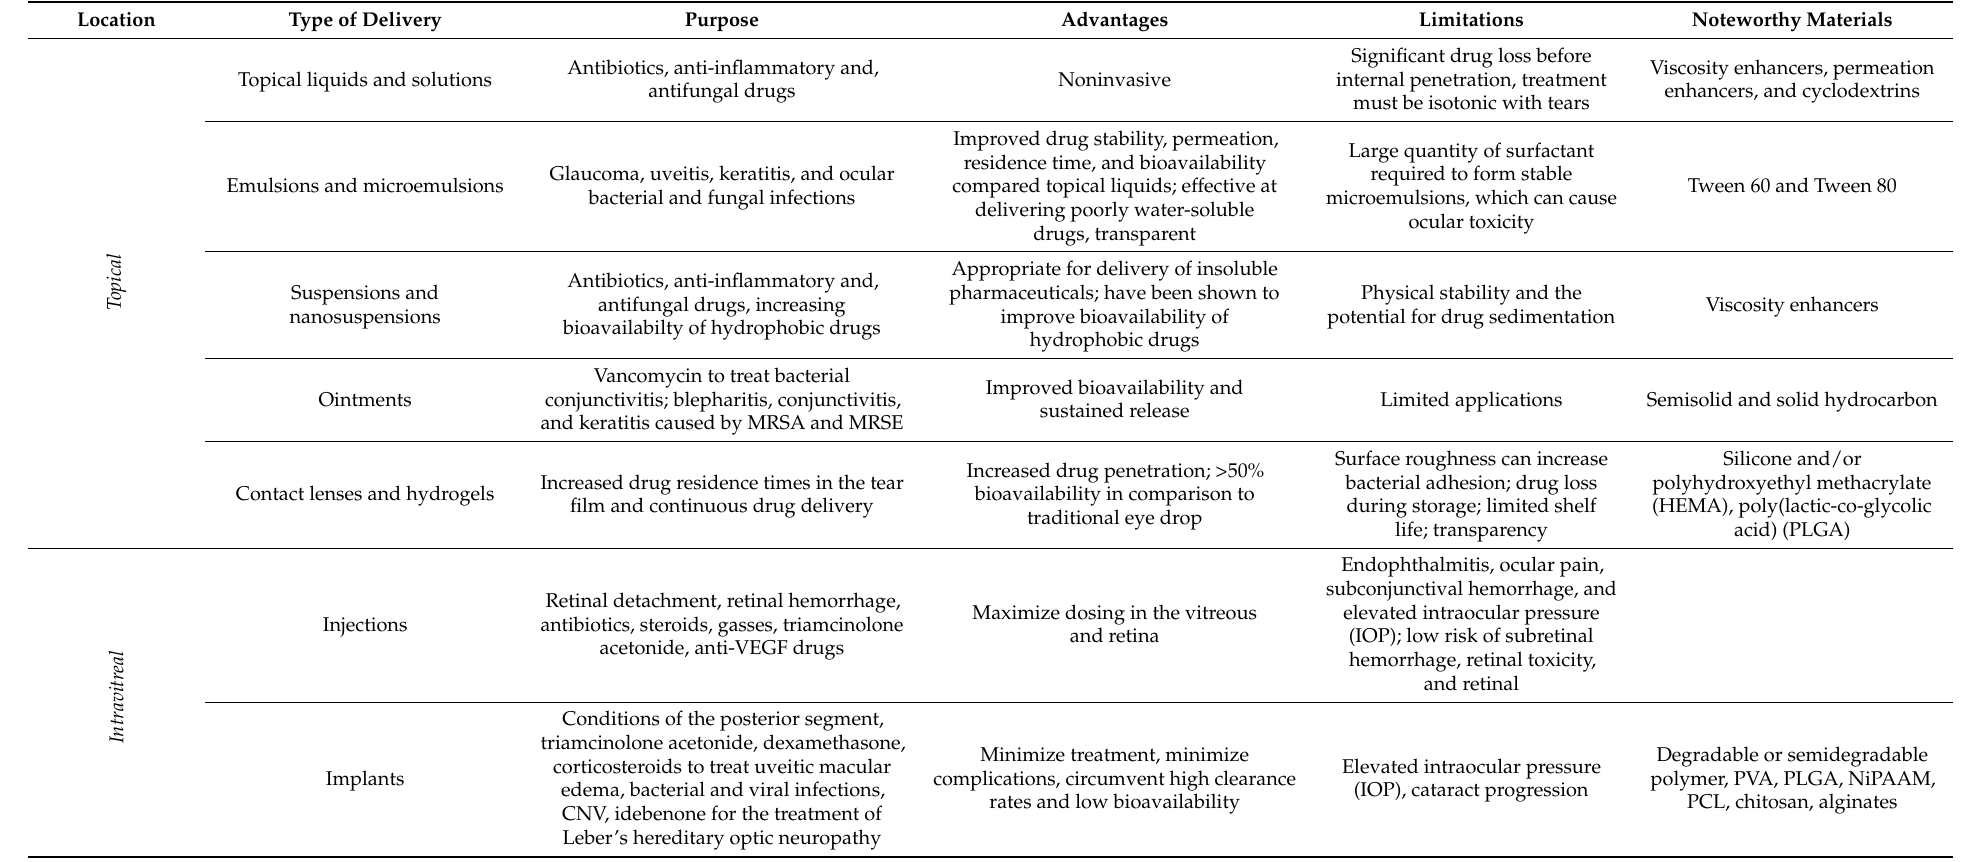
Table 1. Summary of the primary delivery modalities including the type of delivery, advantages, disadvantages, and noteworthy materials